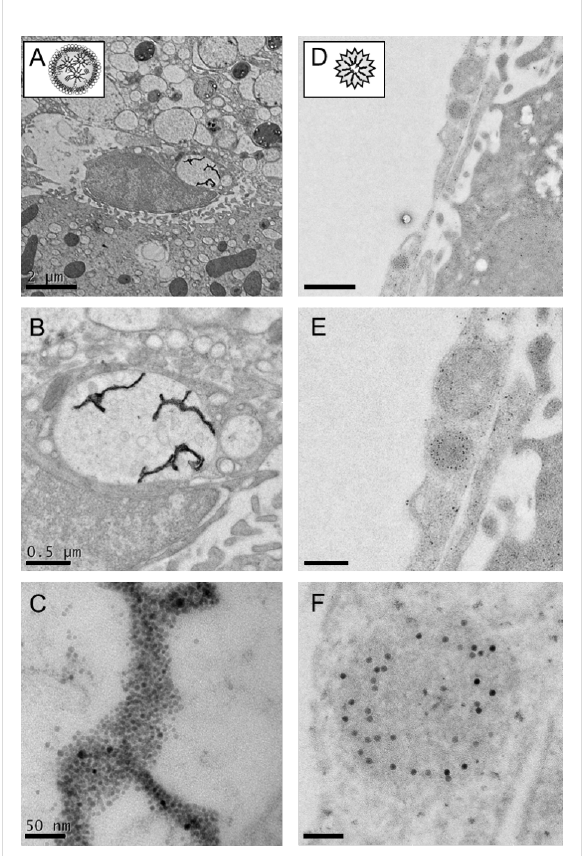
Figure 2: Cryo-electron microscopy of hepatic nanocrystals uptake. SPIOs-micelles (left panel) or polymer-embedded SPIOs (right panel) were injected into wild type C57BL/6 mice. 30 min after injection, mice were perfused with 2% paraformaldehyde in PBS and livers were processed for electron microscopy. (A–C) The pictures highlight a Kupffer cell 30 min after the injection of SPIOs-labelled lipid micelles. Clustered nanocrystals of lipid micelles can be detected within intracel- lular compartments, probably a lipid droplet-like structure of the cell. (D–F) Polymer-coated SPIOs can be found in endosomal structures of endothelial cells. Scale bars correspond to 2 µm (A,D), 0.5 µm (B,E) and 50 nm (C,F),